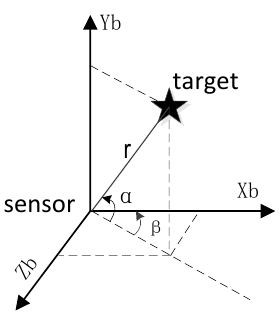
Figure 2. Measurement of target in body coordinate